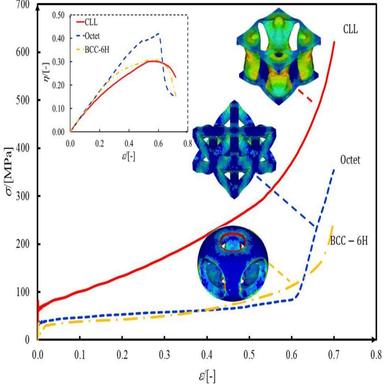
Compressive properties of lattice materials ( ¯ 0.261 = ) with different cell topologies, i.e. CLL, Octet and BCC-6H.